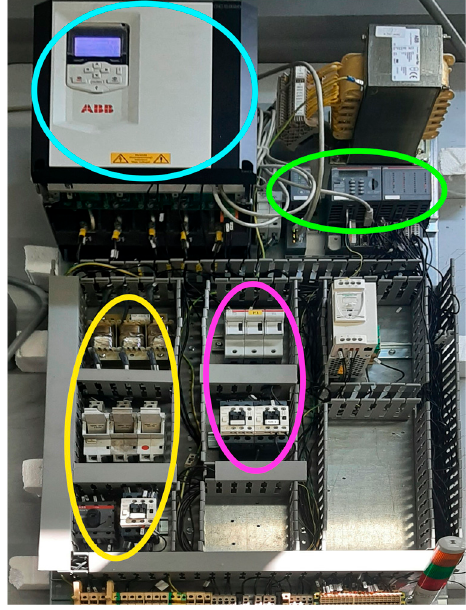
Figure 5. A picture of the laboratory-assembled electrical panel.